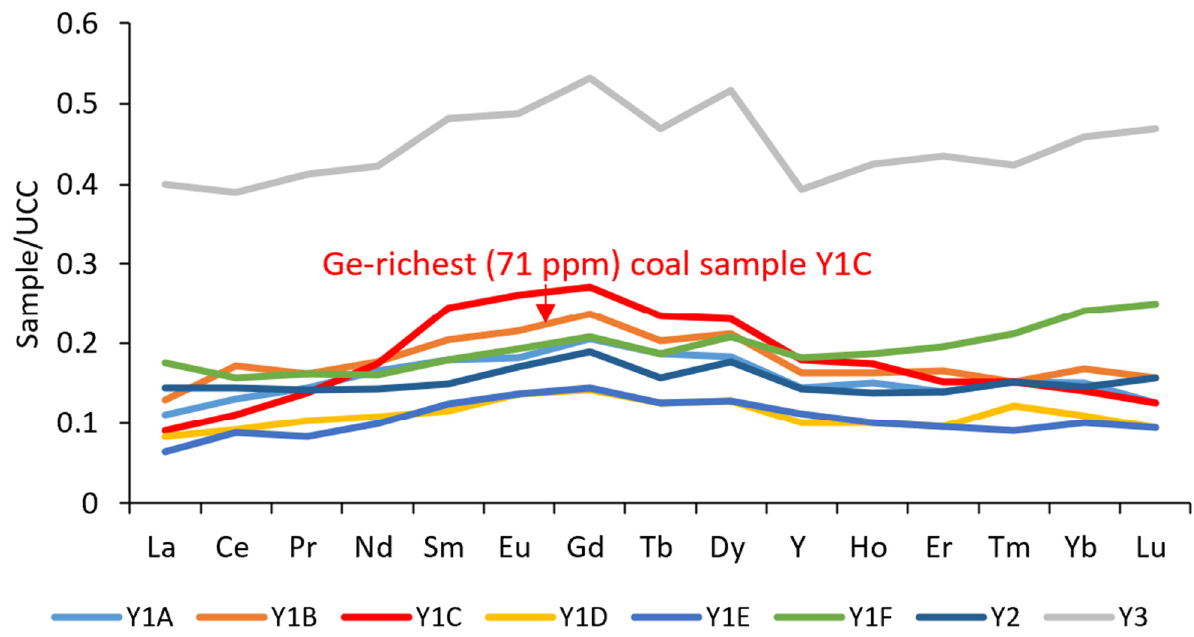
Figure 19. REY distribution patterns of Ge-rich coals from the Yimin deposit (based on the data from Li et al. [135]). Li et al.